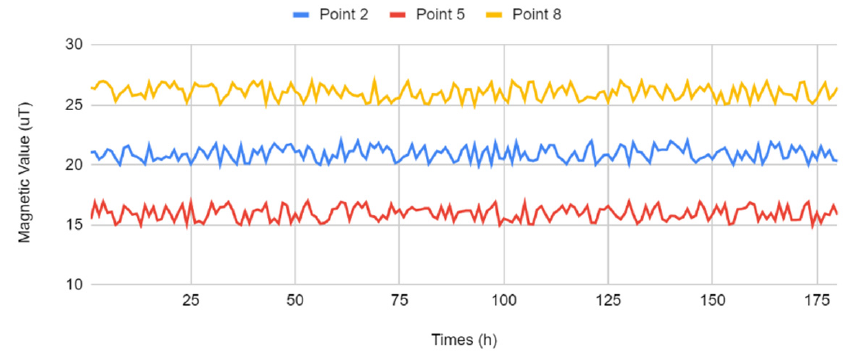
Figure 6. Variation in the curve of magnetic intensity values at different sampling points.